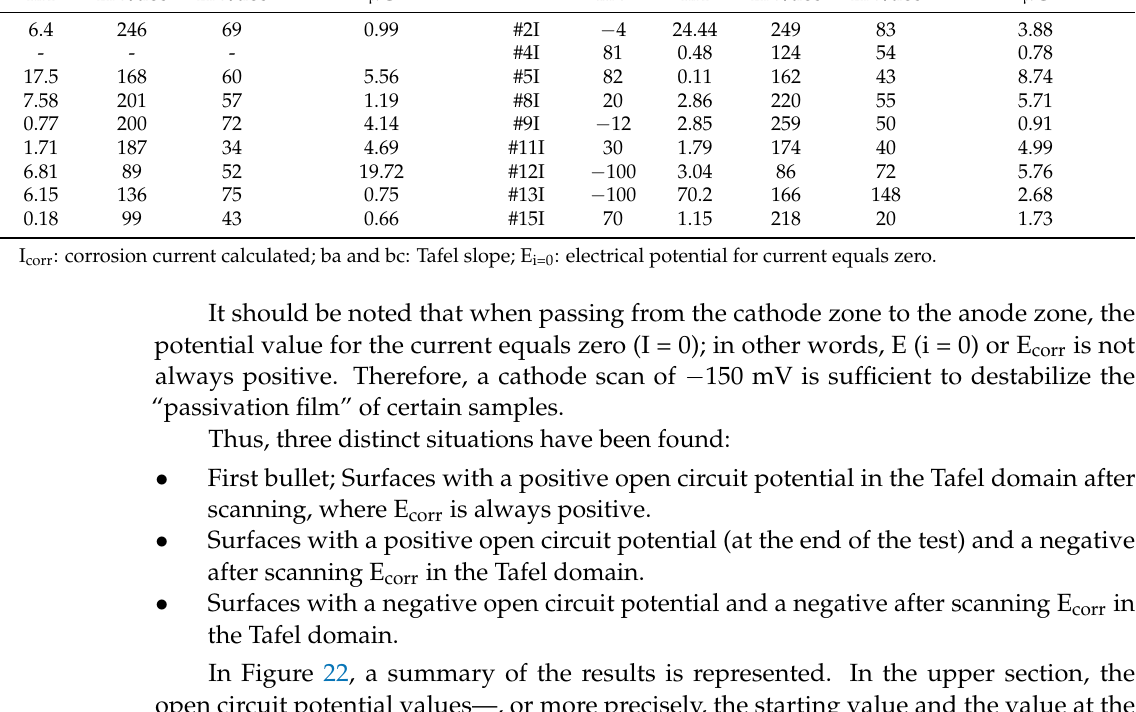
Table 7. Electrochemical parameters measured and calculated in the Tafel domain. E: external surface; I: internal surface.